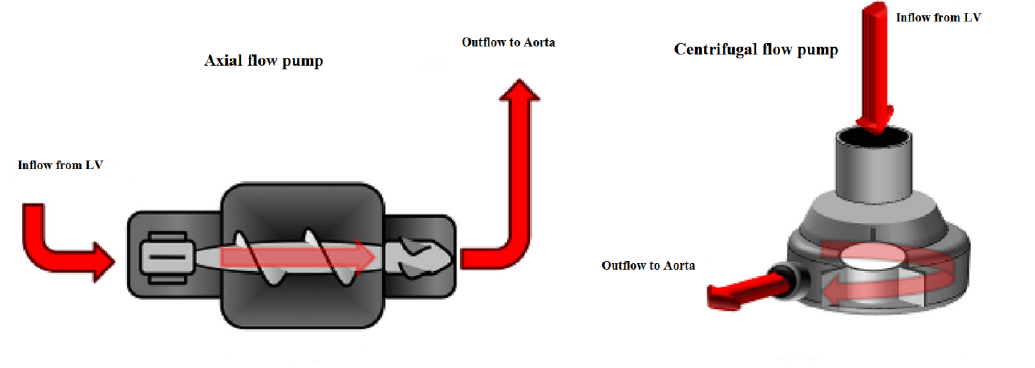
Figure 3: Axial and centrifugal flow pump [37].